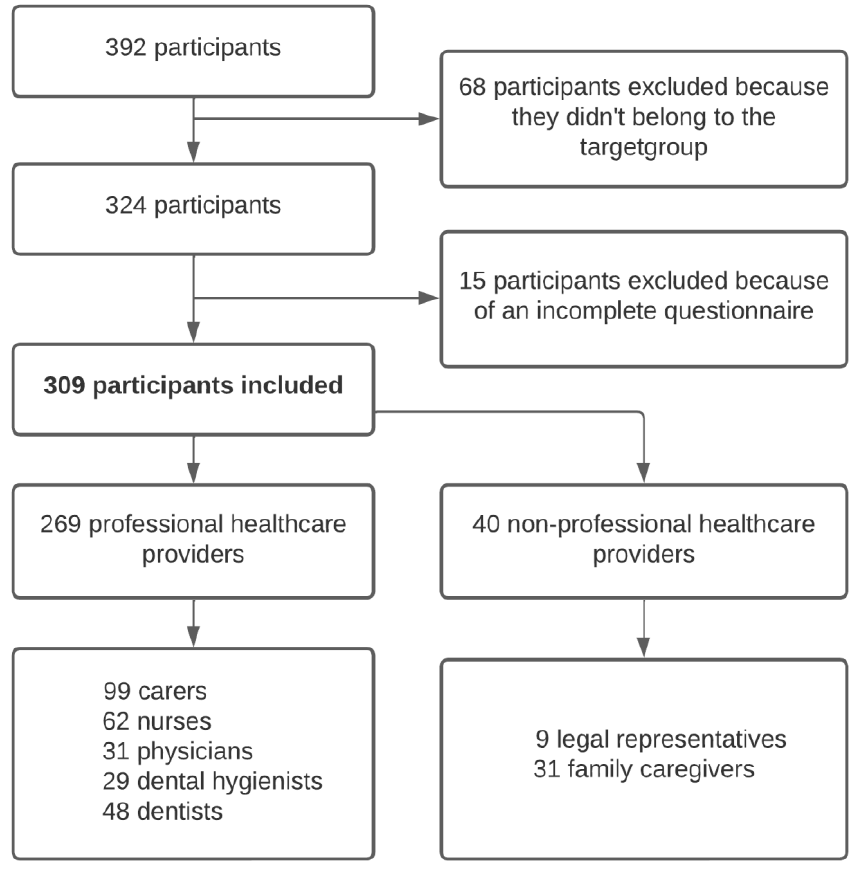
Figure 1. Flowchart of study population .